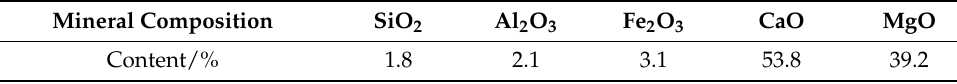
Table 1. Mineral composition of limestone. Mineral